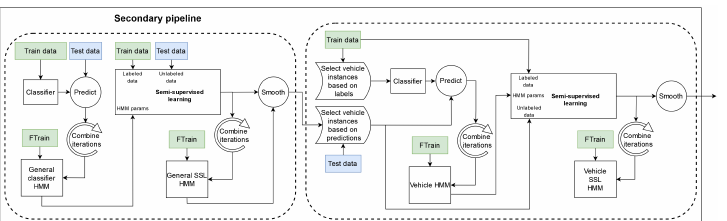
Figure 5. A diagram of the secondary (parallel) pipeline that provides the relevant HMM